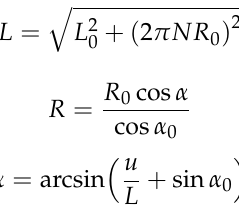
Figure 3. Schematic of a shape memory alloy (SMA) helical spring.